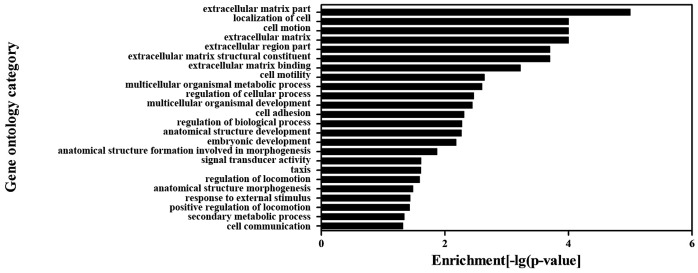
The GO category for the down-regulated genes in clopidogrel group.A P value <0.05 was used as a cut-off threshold to select significant GO categories. The higher the enrichment, the more significant the biological processes.